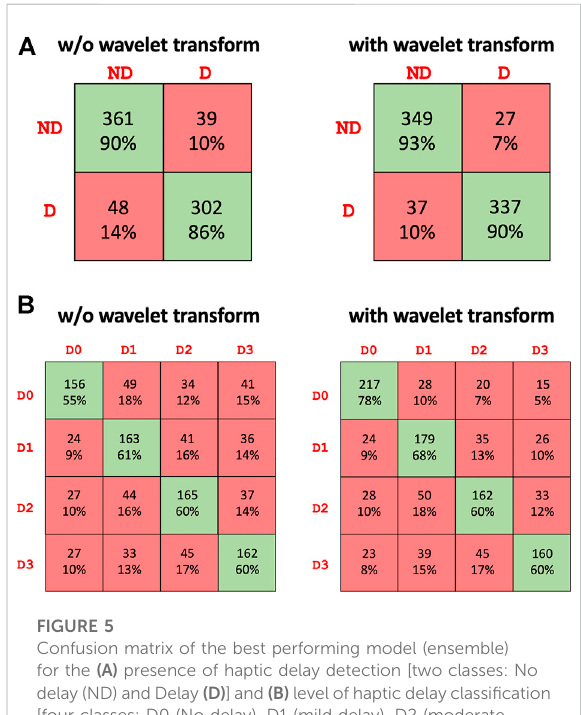
FIGURE 5 Confusion matrix of the best performing model (ensemble) for the (A) presence of haptic delay detection [two classes: No delay (ND) and Delay (D) ]and (B) level of haptic delay classi fi cation [four classes: D0 (No delay), D1 (mild delay), D2 (moderate delay), D3 (severe